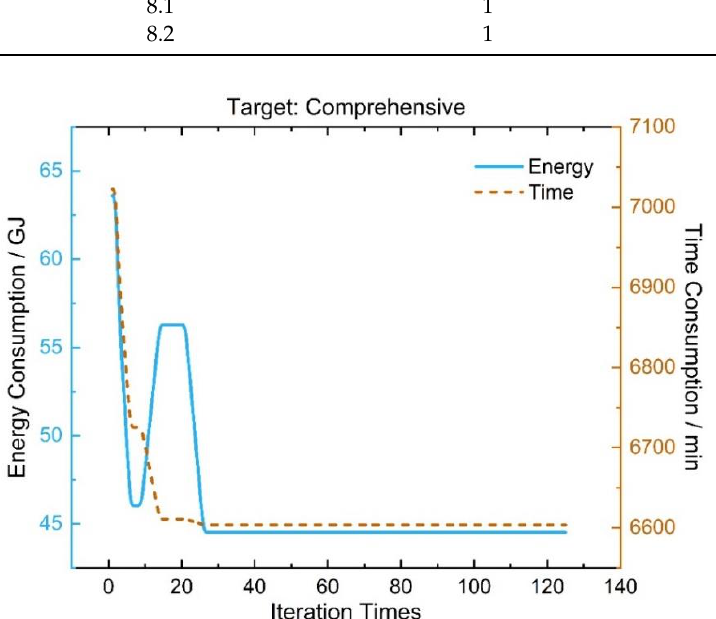
Figure 4. The change in time and energy consumption of batch 4 in the iterative process. According to the results in Table 5, the final results obtained using the scheduling method in this work are better than those obtained by the simulated annealing